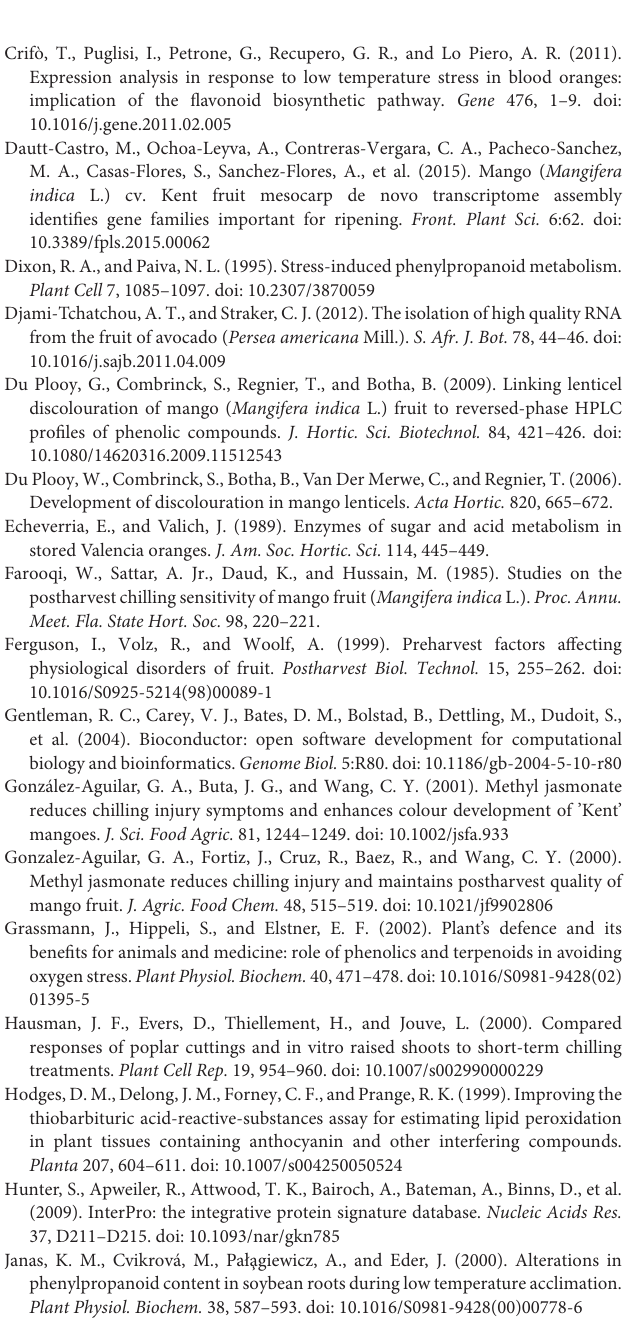
FIGURE S6 | Activation of starch, sucrose and galactose metabolism- related genes in response to cold storage. (A) Starch, sucrose, and galactose metabolism based on the KEGG pathway mapper. Genes circled in red are significantly upregulated during cold storage at 5 ◦ C. (B) Expression heat maps of genes related to starch, sucrose and galactose metabolism at two different storage temperatures (5 and 12 ◦ C) at different sampling times (2, 7, and 14 days). Abbreviations, transcript identification and expression profile are described in Supplementary Table S2 . TABLE S1 | Mango ‘Keitt’ transcript expression profile at harvest and at 2, 7, and 14 days of cold storage. Shown are: Transcript ID (comp number), gene description (based on Blast2GO annotation), KEGG number, GO description,